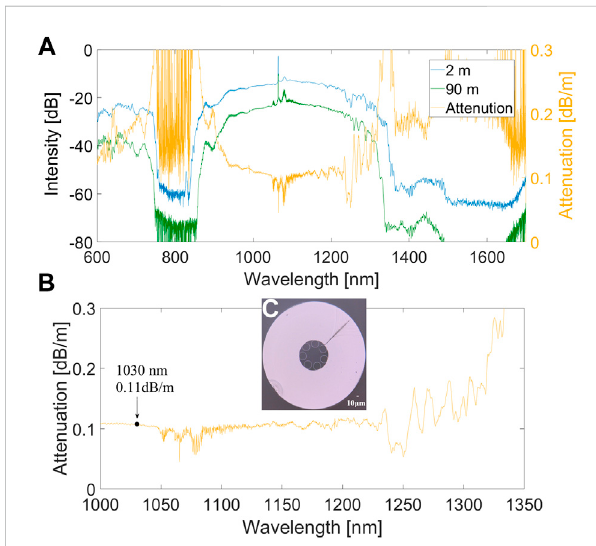
FIGURE 1 (A) Measured transmission spectra of the 2 m (solid blue curve) and the 90 m (solid green curve) AR-HCF and attenuation spectrum (solid yellow curve) in the range of 600 nm – 1700 nm. (B) Detailed attenuation spectrum measured in the near-infrared range of 1,000 nm – 1,350 nm (solid yellow curve). (C) Cross setion of seven capillaries AR-HCF with 45-µm-core